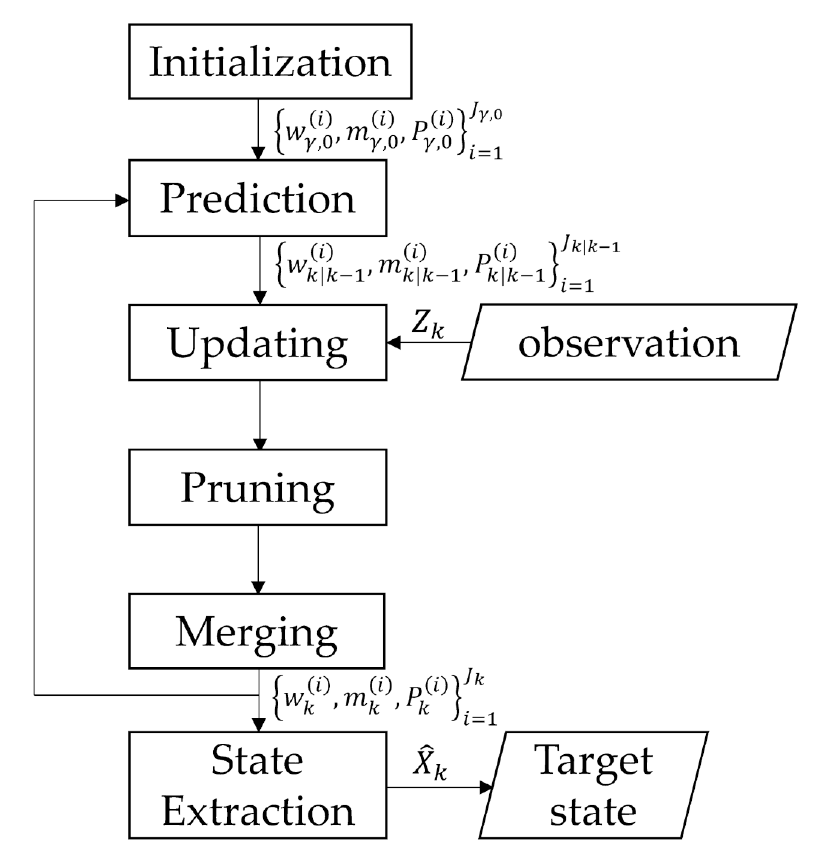
Figure 1. Overall procedure of the basic GM-PHD filter.